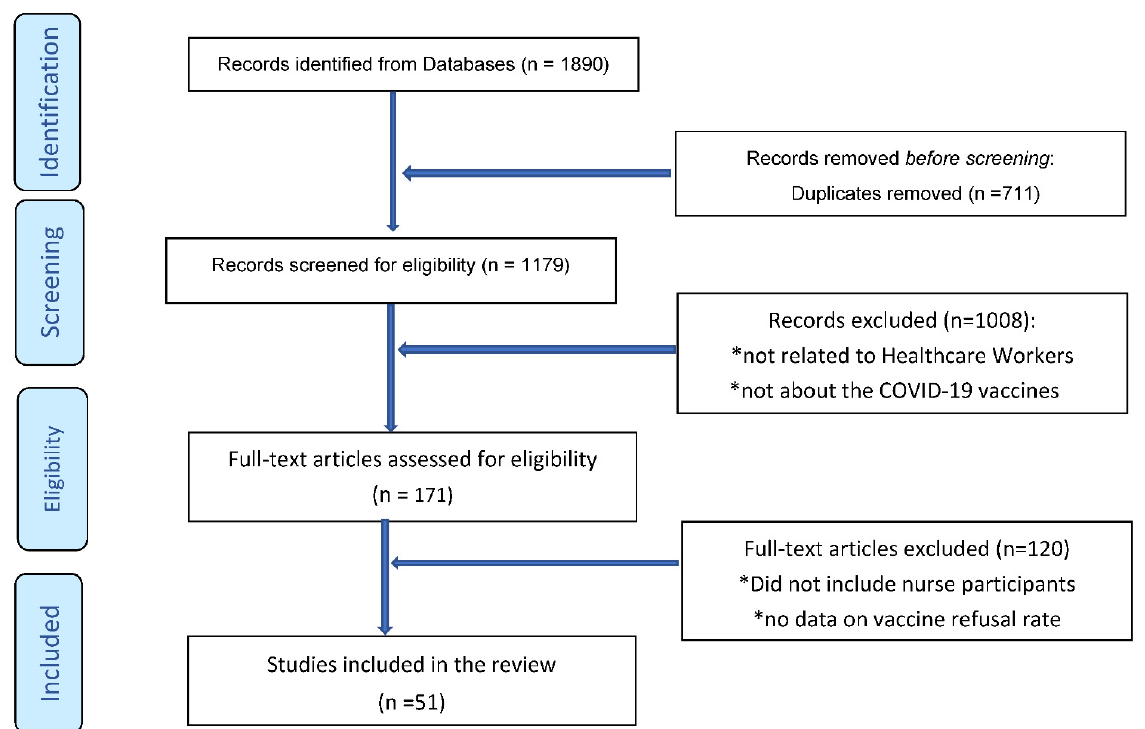
Figure 1. PRISMA Flowchart: Scoping Review of Nurses’ COVID-19 Vaccination Refusal.